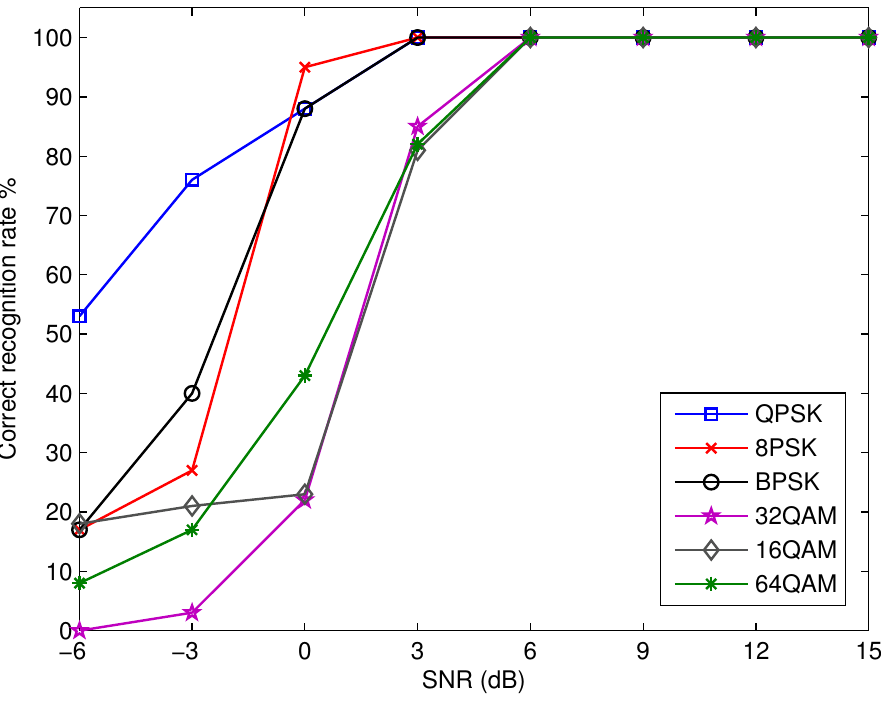
Figure 6. The recognition performance of the proposed